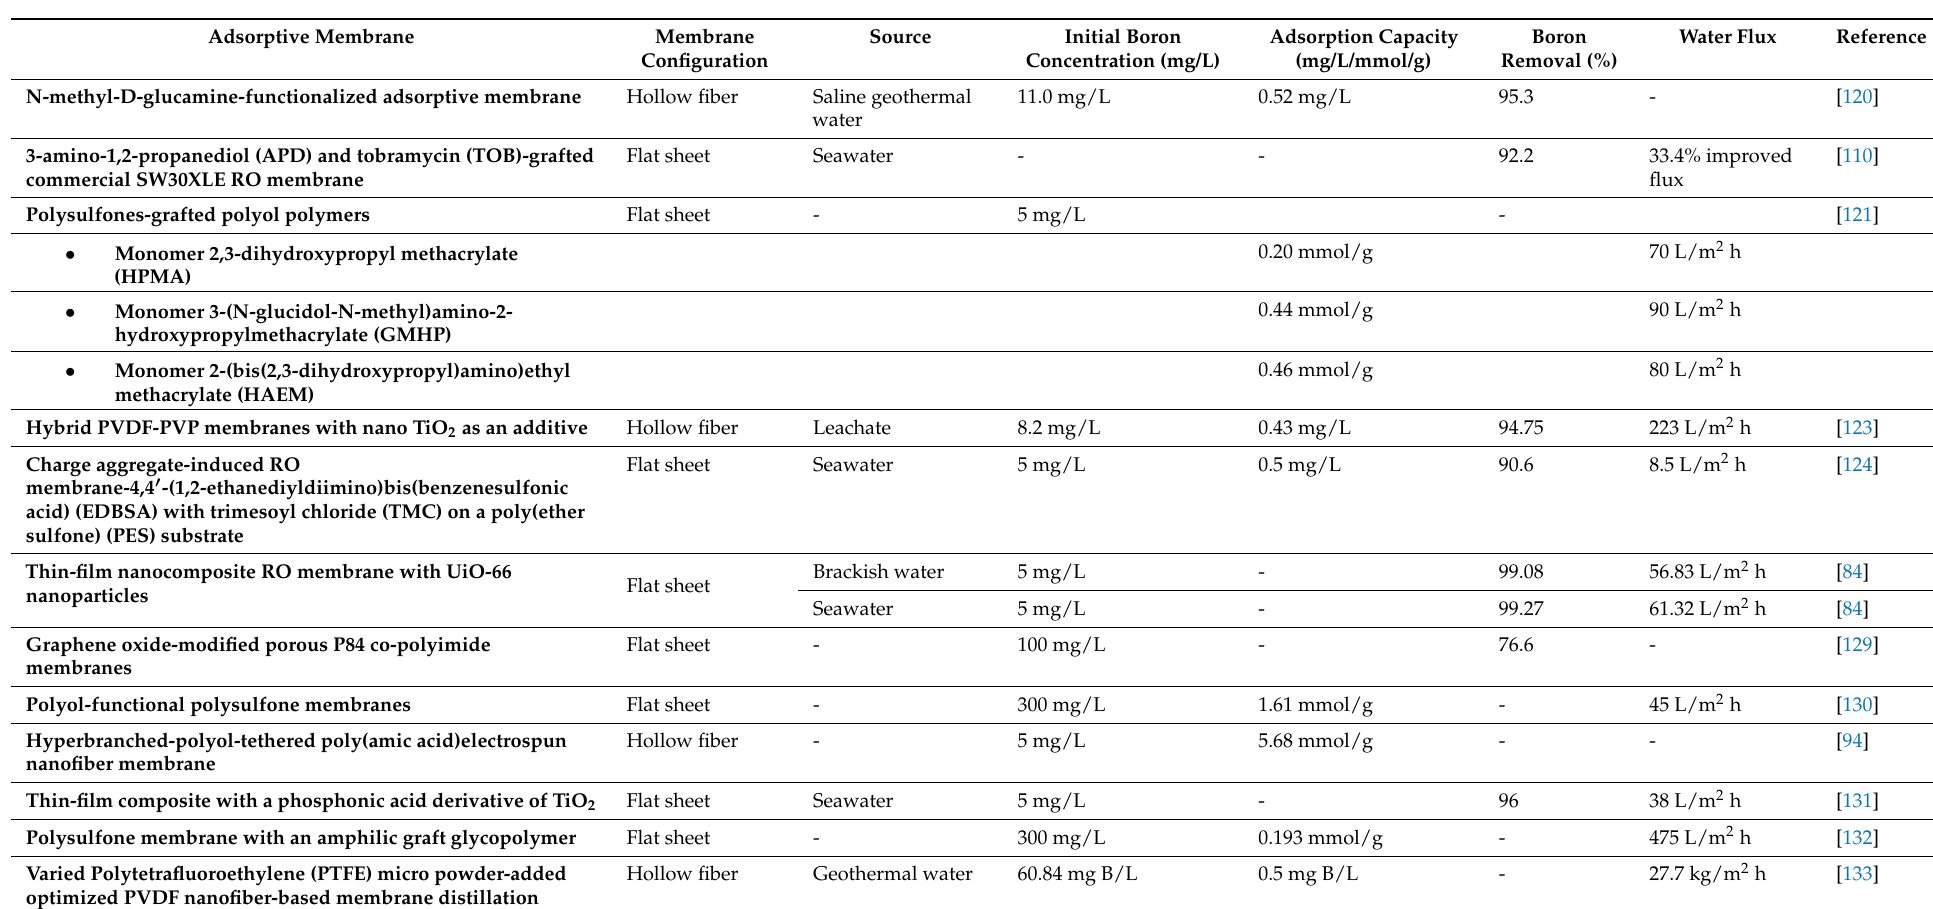
Table 4. Previous studies about boron removal by adsorptive